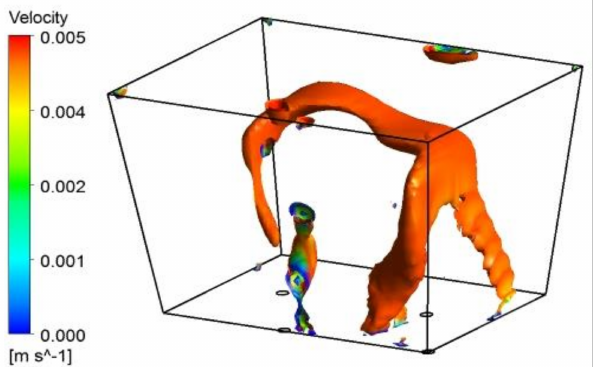
Figure 11. Three-dimensional visualization of dead region in the discharging